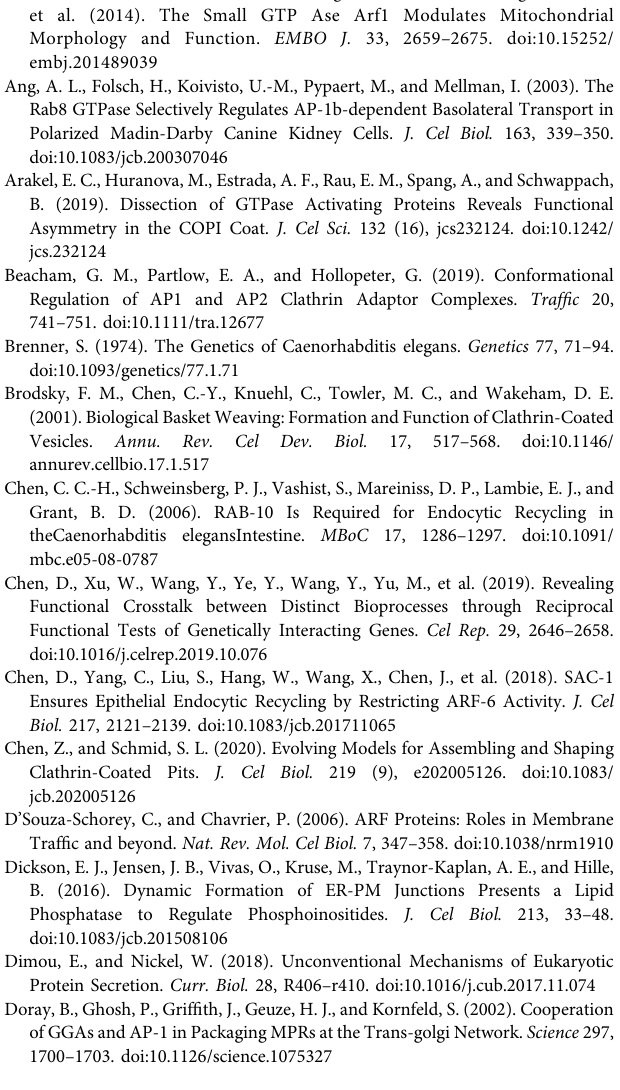
Supplementary Figure S5 | (A) Confocal image showing colocalization between PI(4)P marker GFP-P4M and SMAP-1-mCherry in the intestinal cells. Arrowheads indicate structures labeled by both GFP and mCherry. (B) Pearson ’ s correlation coef fi cients for GFP and mCherry signals are calculated, error bars are 95% CIs ( n (cid:1) 12 animals). Scale bar represents 10 μ m.